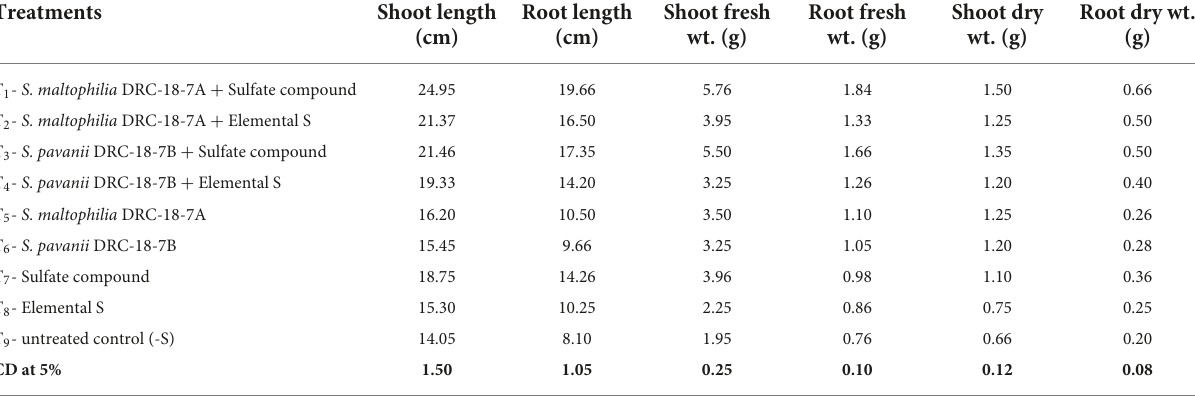
TABLE 1 Effects of inoculation on plant growth attributes in pigeonpea at 30 days of sowing under glasshouse conditions. Treatments Shoot length